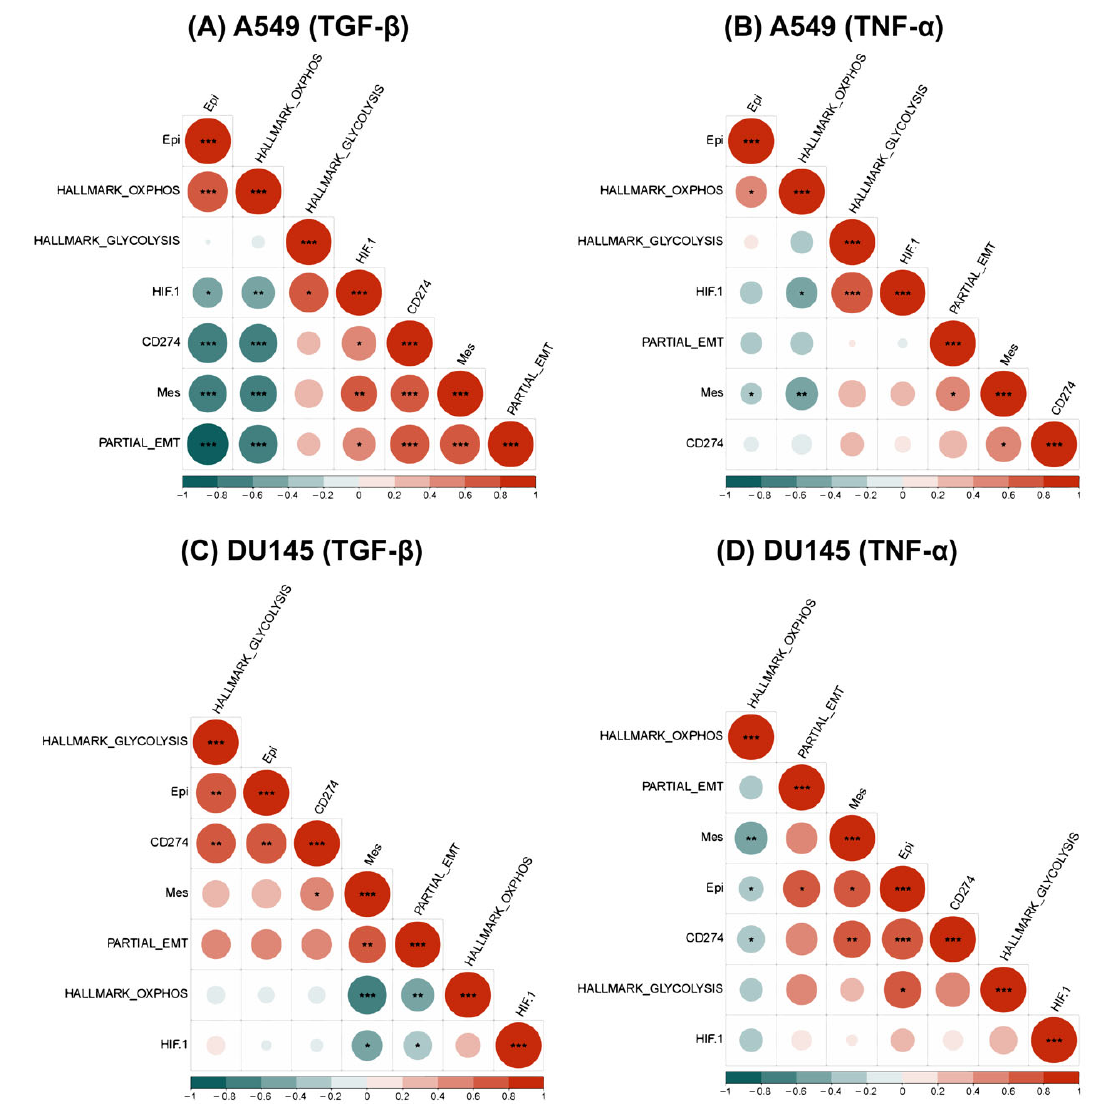
Figure 4. Association between EMT and metabolic axes with CD274 gene expression in single-cell RNA sequencing data (GSE147405). ( A ) Heatmap illustrating correlation coefficient ‘R’ for EMT metrics, metabolic pathways, and the CD274 gene in TGF- β -treated A549 cell line. p -values are calculated using unpaired Students’ T-test with unequal variance and significant correlations are marked with an asterisk (*) for p < 0.05; **: p <0.01; ***: p < 0.001. ( B ) Same as ( A ) but for TNF ‐α‐ treated A549 cell line. ( C ) TGF ‐β‐ treated DU145 cell line and ( D ) TNF ‐α‐ treated DU145 cell line.